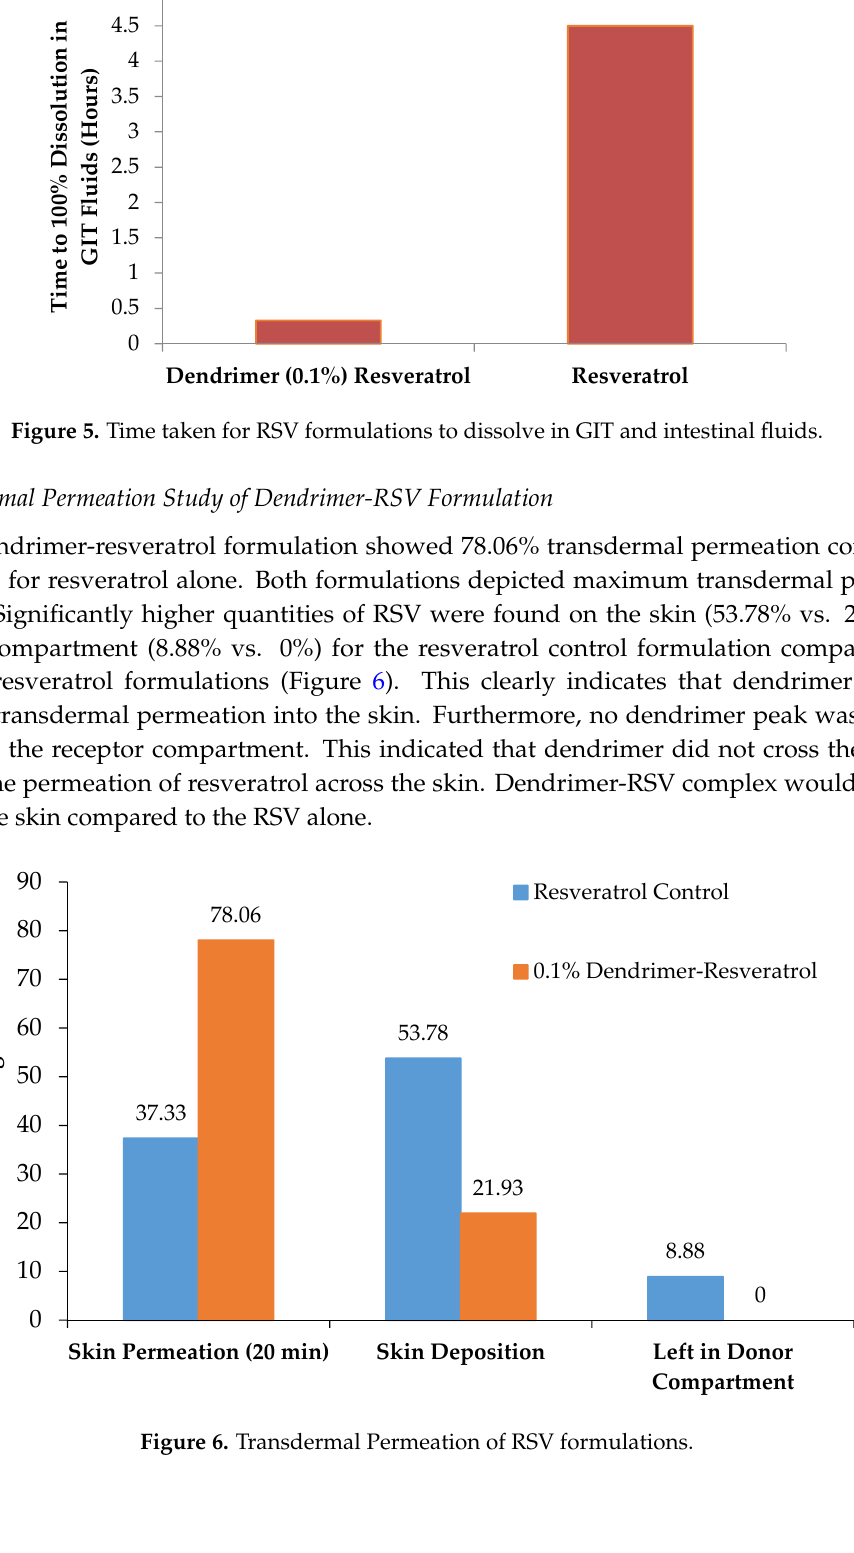
Figure 7. Chromatogram illustrating stable and degraded RSV peaks.